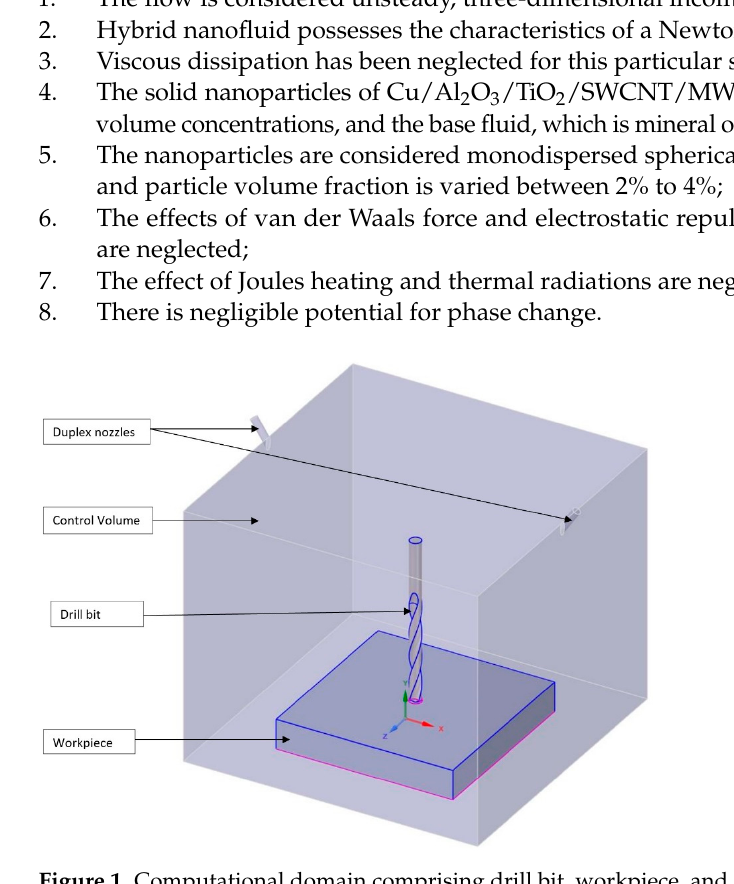
Figure 1. Computational domain comprising drill bit, workpiece, and duplex nozzles.